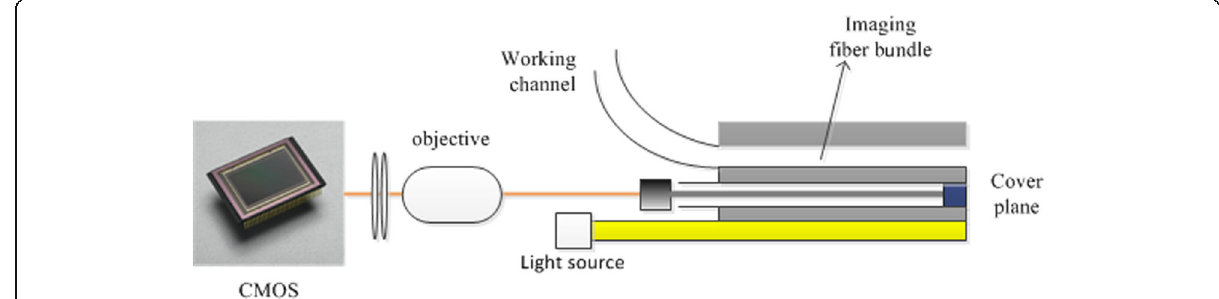
Fig. 1 Schematic of the bimodal endoscope hardware